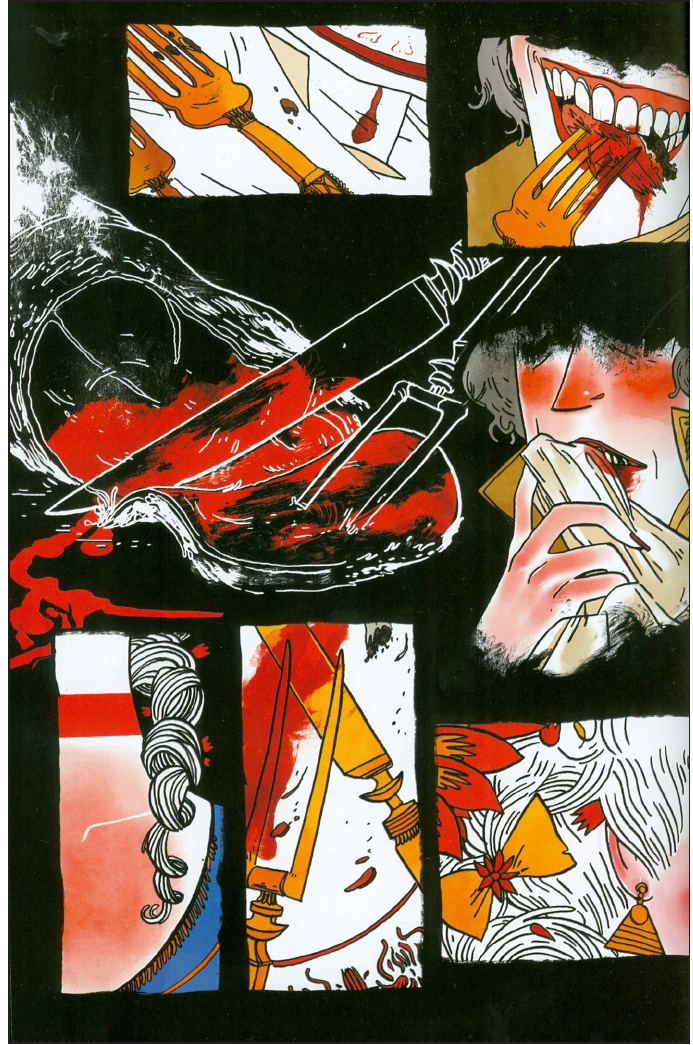
Figure 2: Carroll, E (2014) . Through the Woods (New York: Faber & Faber, n.pag.) © Emily Carroll